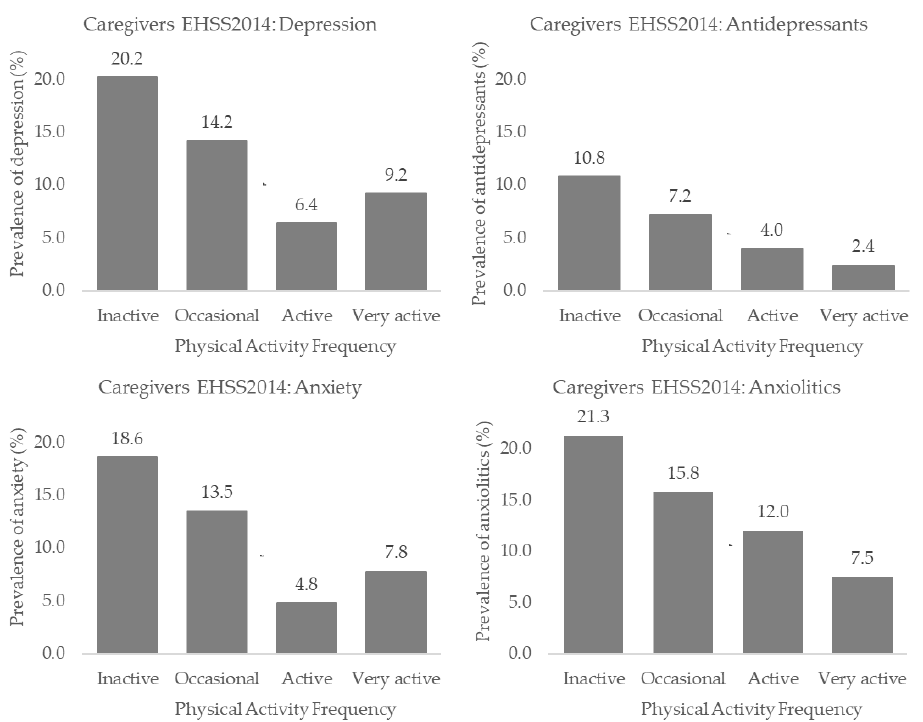
Figure 2. Depression and anxiety and antidepressants and anxiolytics use proportions according to the physical activity frequency in Spanish informal caregivers from the EHSS 2014.